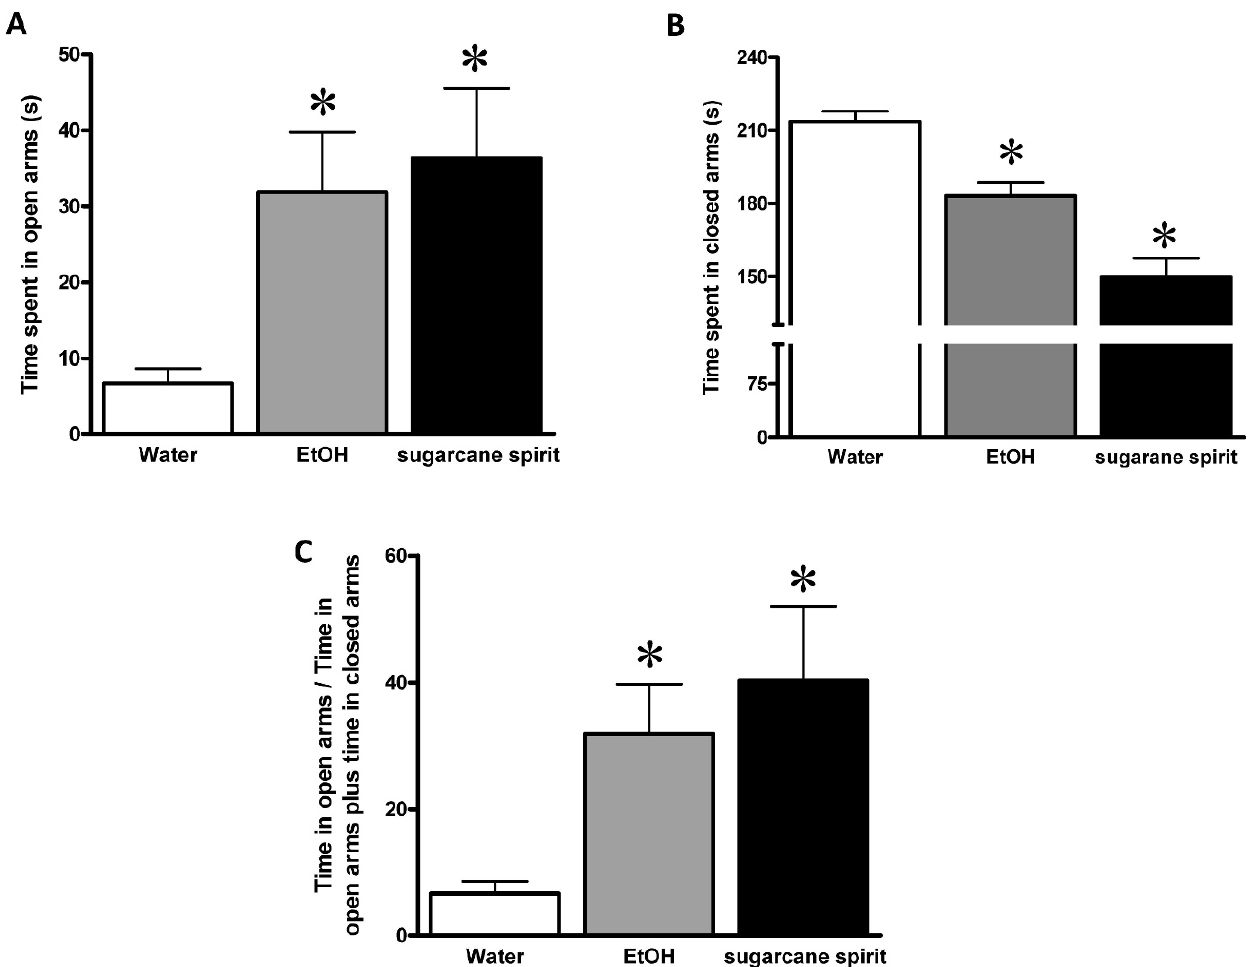
Figure 3 - The elevated-Plus Maze Test. A . The time spent (in seconds) in the open arms during the 5-minute testing period. B . The time spent (in seconds) in the closed arms during the 5-minute testing period. C . The ratio of the time spent in the open arms to the total time spent in both arms during the 5-minute testing period. The data are presented as the mean ¡ SEM. * p , 0.05 compared to the controls (water).